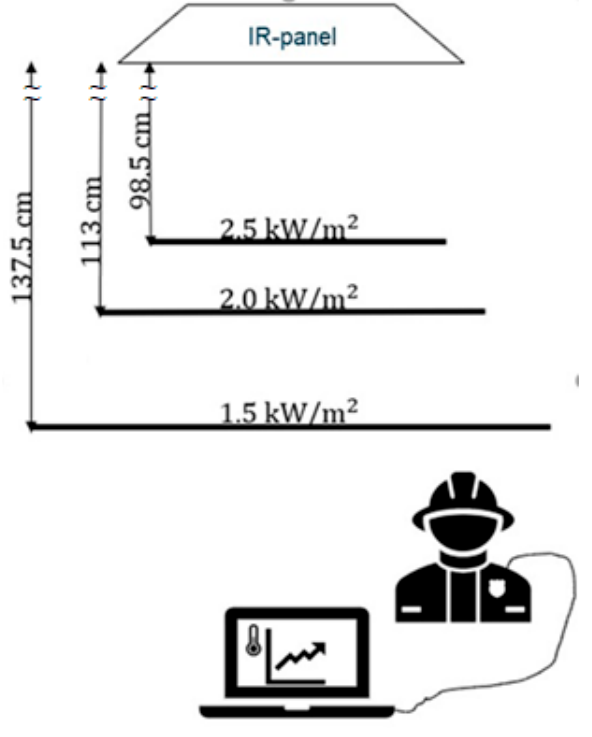
Figure 3. Measurement setup.